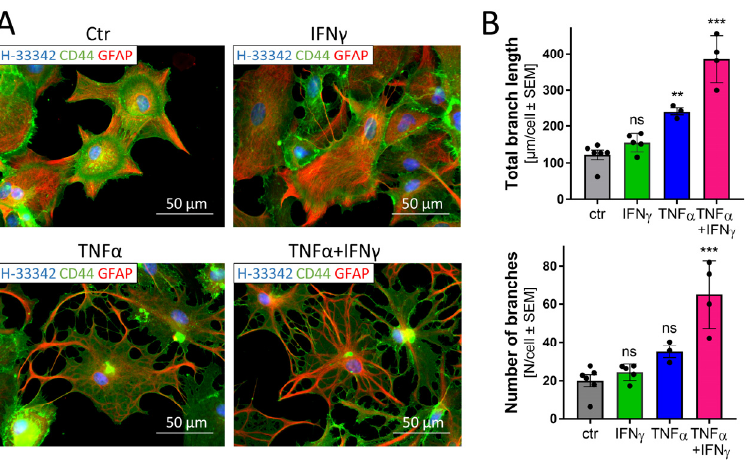
Figure 8. Morphological changes in astrocytes triggered by inflammatory stimuli. ACs (50,000 cells/cm 2 ) were seeded on Matrigel™ ‐ coated glass cover slips in 24 ‐ well plates. After stimulation for 72 h with TNF α (10 ng/mL), IFN γ (20 ng/mL) or the combination of TNF α plus IFN γ , cells were fixed and stained with anti ‐ CD44 and anti ‐ GFAP antibodies and visualized using an epifluorescence microscope (63× oil objective). Nuclei were counterstained with Hoechst ‐ 33342. ( A ) Representative images. ( B ) The AC morphology was analyzed using an algorithm determining branch length and the number of branches per cell. Three to five fields (black data points) with an average of about 100 cells per condition were analyzed. Ctr.: untreated ACs. ** p < 0.01; *** p < 0.001 according to ANOVA with Dunnett’s post hoc test. ns, not significant.